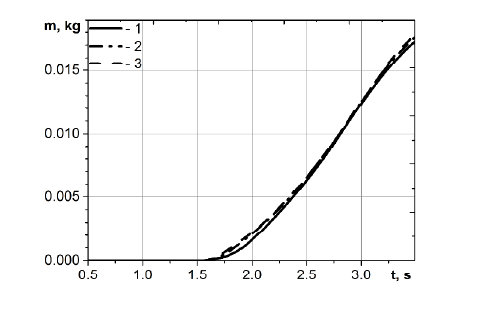
Fig. 2. Mass of the melt. The results of simulation for a different number of calculation cells. 1 – 40 cells; 2 – 80 cells; 3 – 160 cells.